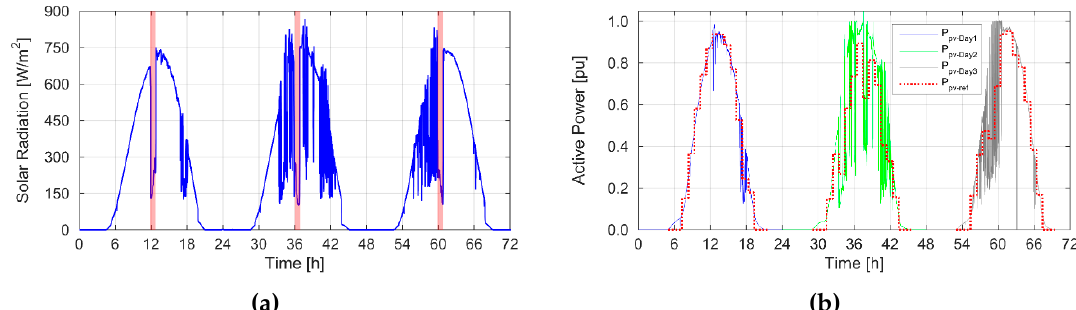
Figure 9. The curves used to develop a battery operation schedule, registered from 23 to 26 July 2018: ( a ) solar irradiation (red bar indicates the time of the day, when the insolation measurement system is overshadowed by other objects installed on the roof of the laboratory), ( b ) per-unit power output of PV system.